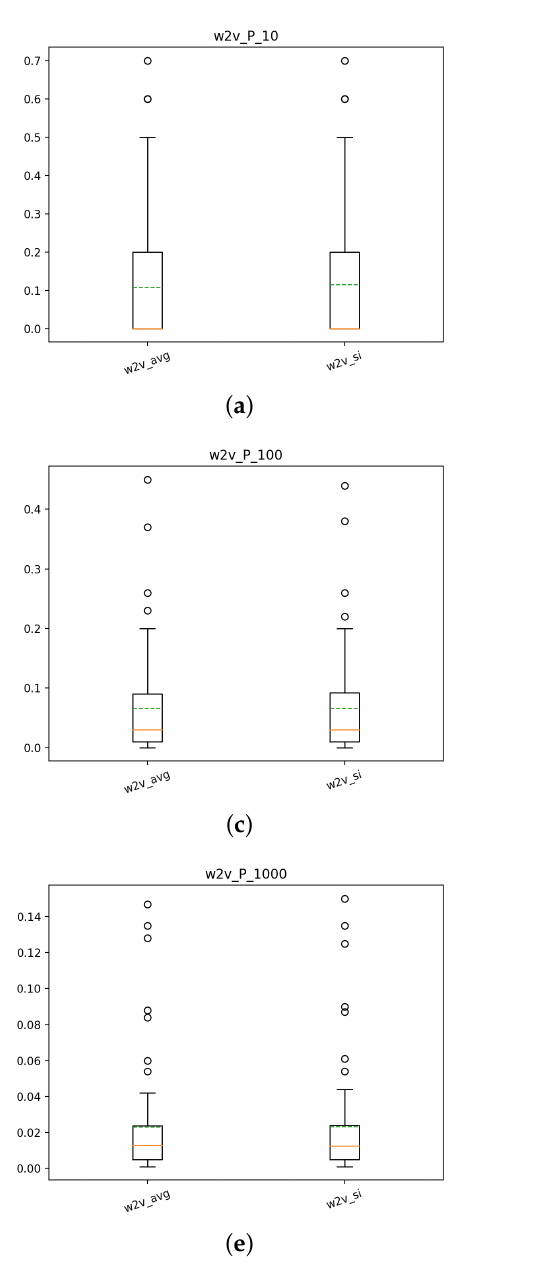
Figure 12. Precision: box plots of the w2v runs: ( a ) T1: P@10 for w2v_avg and w2v_si, ( b ) T2: P@10 for w2v_avg and w2v_si, ( c ) T1: P@100 for w2v_avg and w2v_si, ( d ) T2: P@100 for w2v_avg and w2v_si, ( e ) T1: P@1000 for w2v_avg and w2v_si, ( f ) T2: P@1000 for w2v_avg and